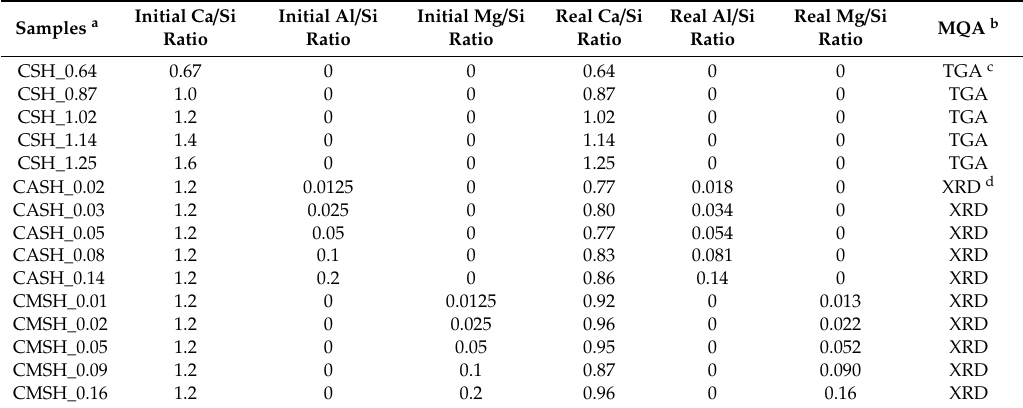
Table 1. The detailed information of synthesized